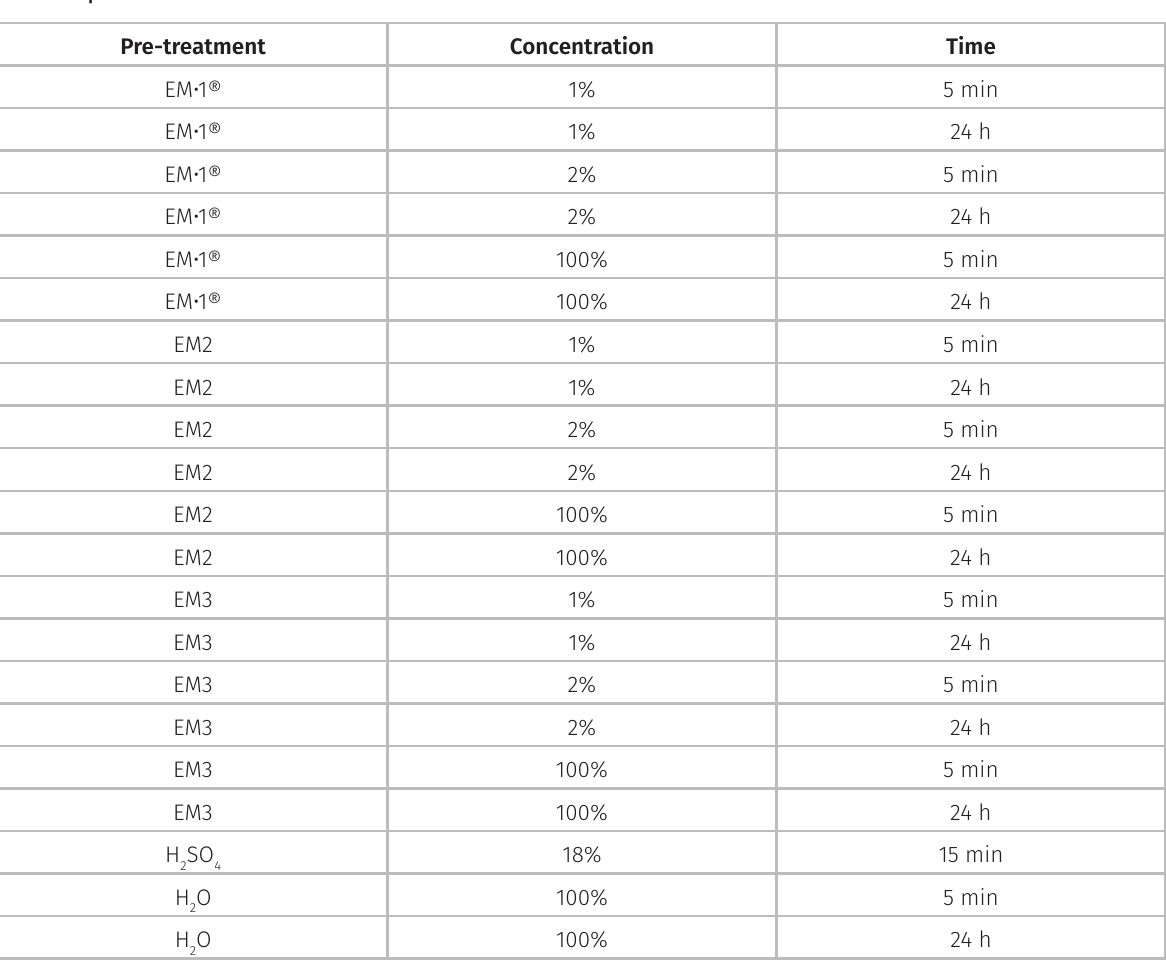
Table I. Experimental treatments. Pre-treatment